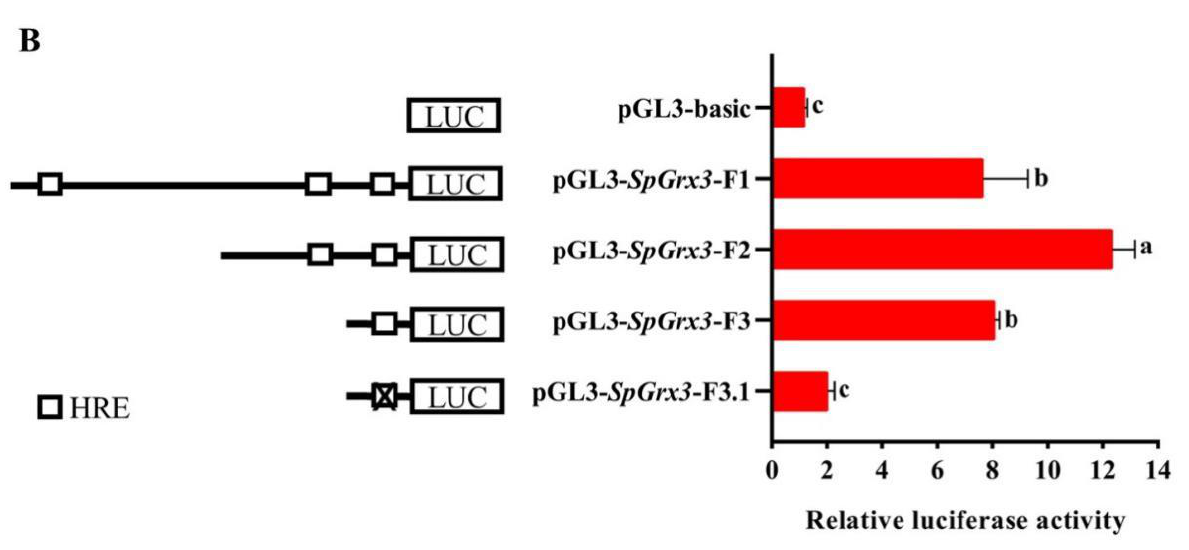
Figure 9. Putative promoter and HRE regulatory elements in the 5′ upstream sequence of SpGrx3 . ( A ) Schematic diagram of the gene promoter region. The transcriptional start site is shown in red font. The predicted HRE is indicated by a black box. The arrow indicates the direction of the HRE motif. ( B ) The activity of each plasmid relative to empty vector (pGL3-Basic) in S2 cells. Different 5′ truncations of the SpGrx3 promoter were individually cloned into the pGL3-Basic vector. The HRE site, CTGCGTGA, was mutated to CTATACAA in pGL3- SpGrx3 -F3.1. S2 cells were co-transfected with the firefly luciferase reporter plasmid, expression plasmids (pAc5.1- SpHIF-1 α -V5), and the control plasmid (pRL-TK Renilla luciferase plasmid). The data are expressed as fold induction relative to the empty vector (pGL3-Basic). The bars represent the mean ± SD (N = 3). p < 0.05.